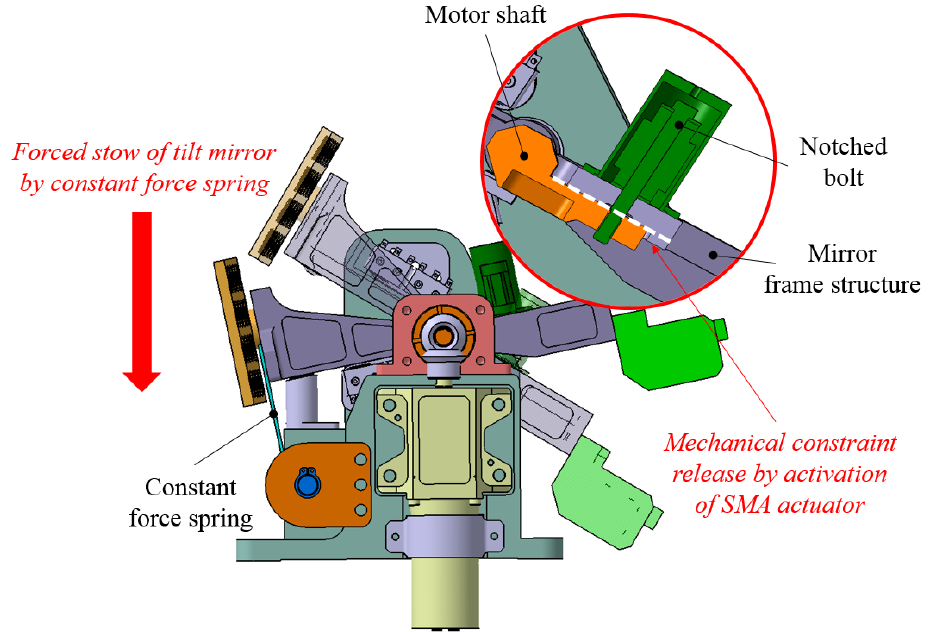
Figure 3. Operation principle of fail ‐ safe function. Table 1. Torque budget estimation results for tilting mirror calibration